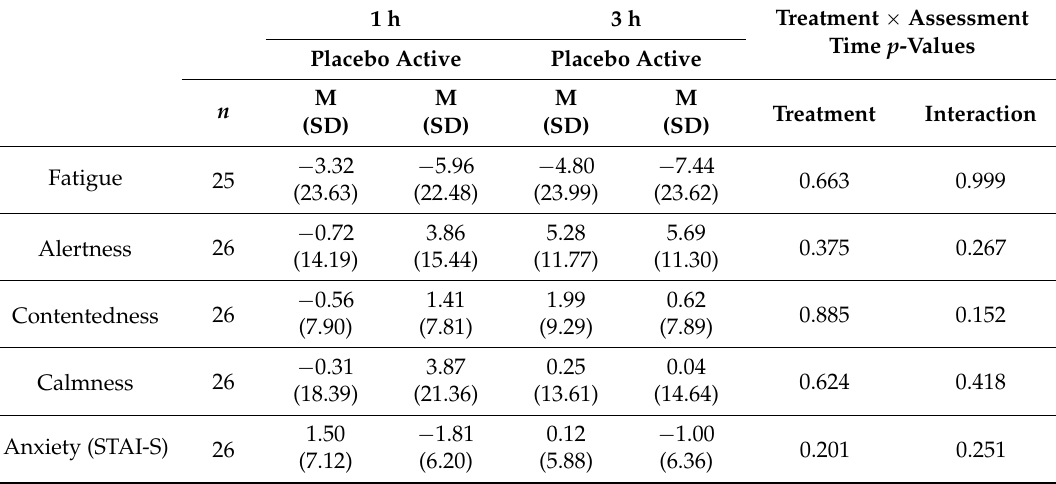
Table 3. Baseline-adjusted mood response to the multitasking framework 1 and 3 h post-dose for both treatments (Mean (M) and SD), with the p -value of the treatment main effect and the treatment by time interaction. STAI-S, State-Trait Anxiety Index.